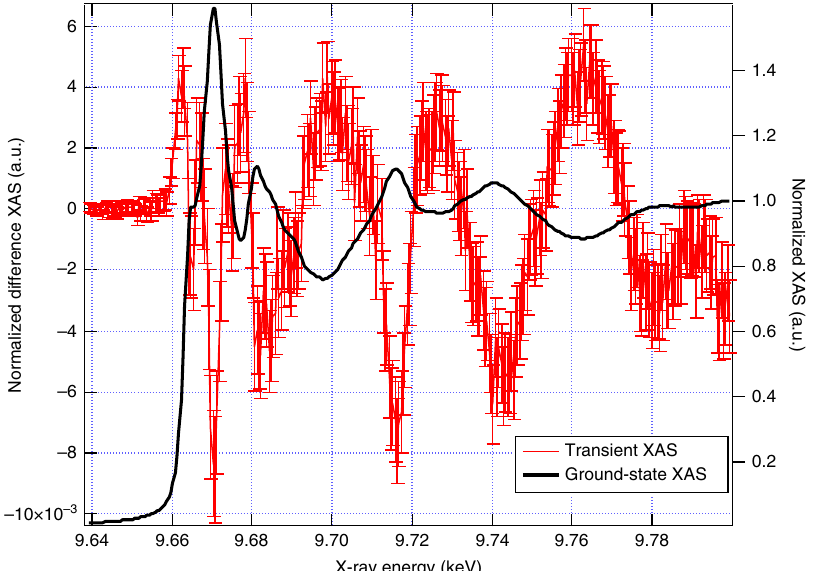
Fig. 2 Ground-state and 80 ps transient X-ray absorption spectrum (XAS). Experimental ground-state XAS (black) and transient XAS difference of the excited minus the unexcited spectra (red) at 80 ps time delay after photo excitation with 355 nm. Error bars shown are the standard error of the experimental measurement